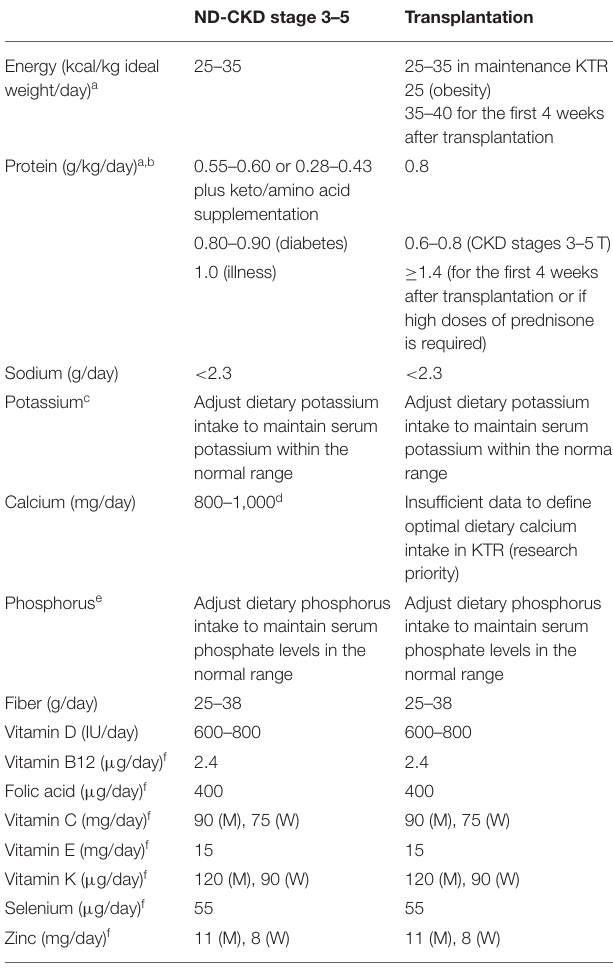
TABLE 1 | Nutritional requirements for patients with non-dialysis CKD according to 2020 KDOQI Guidelines